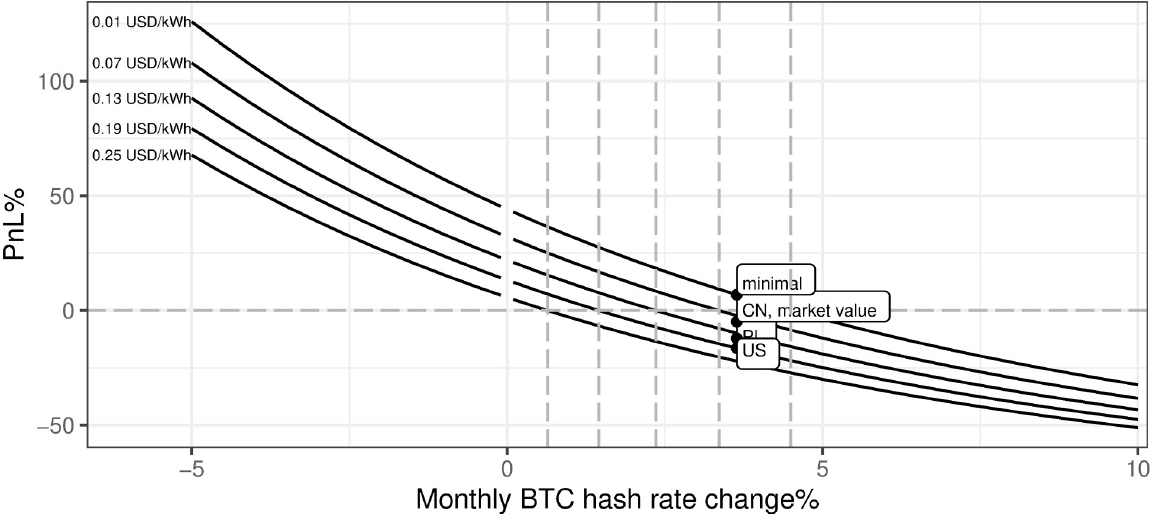
Fig 31. BTC mining profitability (PnL%) for different evolutions of BTC network hash rate and different levels of energy prices. Note: PnL %, calculated according to the formula 6. Hypothetical monthly BTC hash rate change ranges from -5% up to 10% and energy price ranges from 0.01 up to 0.25 USD per kWh. A negative monthly BTC hash rate change means decreasing the BTC network hash rate. Minimal, CN, PL, and US define respectively minimal world energy price level, China, Poland, and US located mining profitability corresponding to the local energy price, provided that remaining parameters are equal. The market value point describes the current state of market mining efficiency assuming parameters outlined in the section Values of variables as of 2021/12/03. Source: own calculations based on data described in section Crucial assumptions and